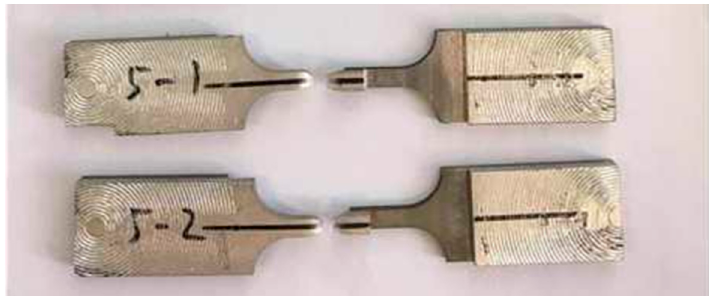
Figure 10. Shear specimens of BM.